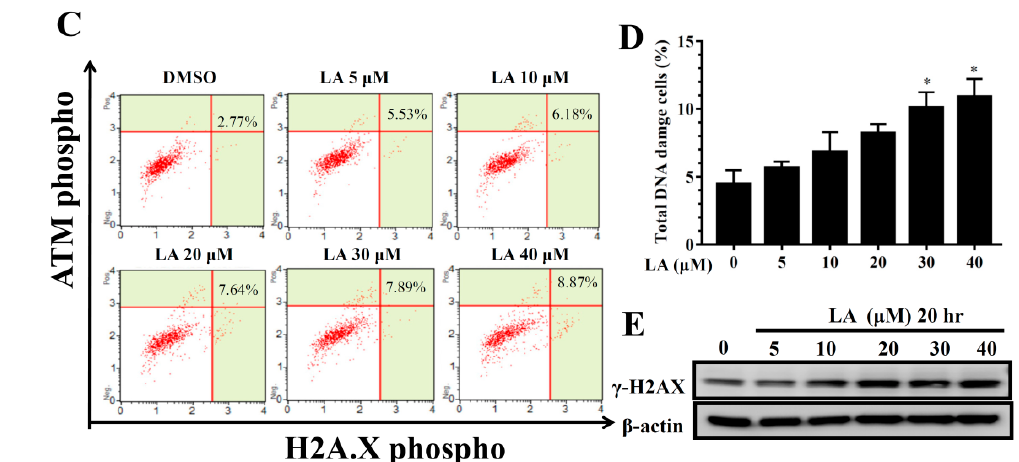
Figure 8. Effect of licochalcone A (LA) on DNA damage in MDA-MB-231 cells. ( A ) Cells were seeded on a culture plate and treated with LA, incubated with γ -H2AX antibodies, and detected by fluorescence microscopy. The cell nucleus was stained with DAPI solution. ( B ) The fold expression of γ -H2AX relative to cells not treated with LA. ( C ) DNA damage assay using the Multi-Color DNA Damage Kit, and cellular DNA damage detected by flow cytometry. ( D ) Percentage of DNA damaged cells in each group. ( E ) γ -H2AX protein expression assessed by Western blot, with β -actin as an internal control. The data are presented as mean ± SD of three independent experiments (n = 6). * p < 0.05, ** p < 0.01 compared to untreated cells (0 µ M LA).